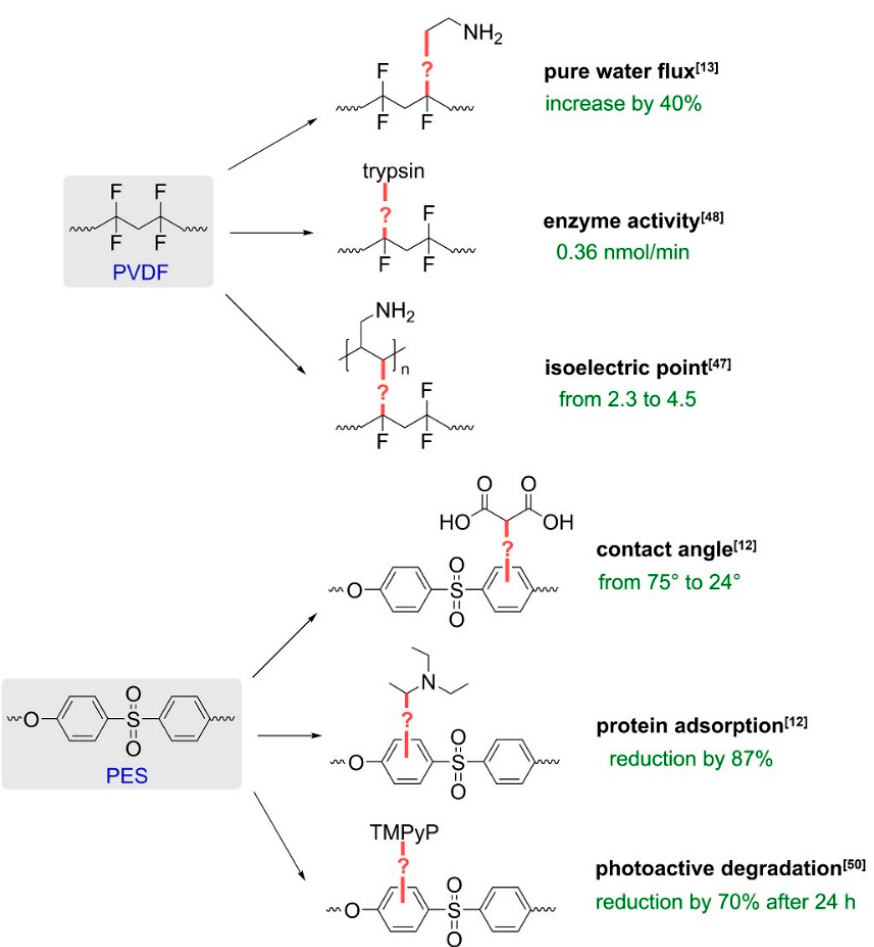
Figure 4. Selection of successful membrane modifications via the RIGI approach. Despite significant improvements, the way of binding the modifying compounds is still unclear.